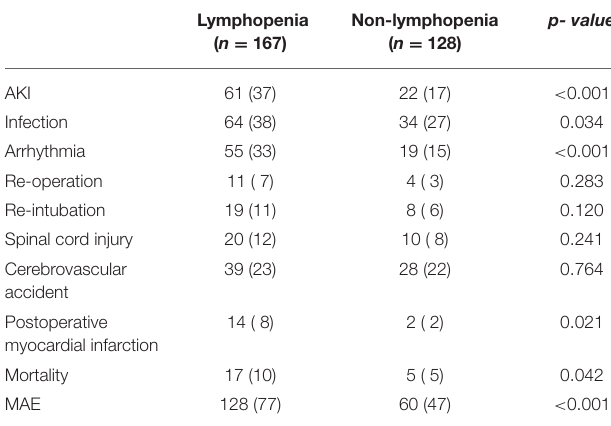
TABLE 2 | Postoperative events of patients with lymphopenia and non-lymphopenia. Lymphopenia ( n =